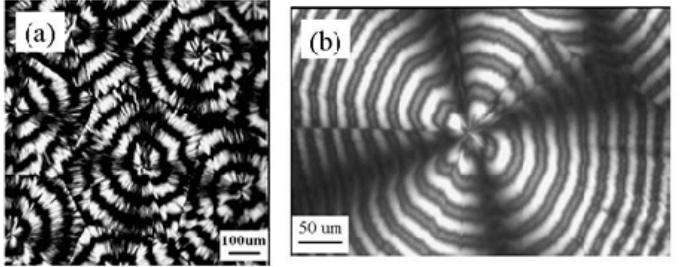
Figure 2. Two types of birefringent banded spherulites observed under polarized optical microscope: ( a ) Single banded spherulites of PLLA; ( b ) double banded spherulite of PHB.